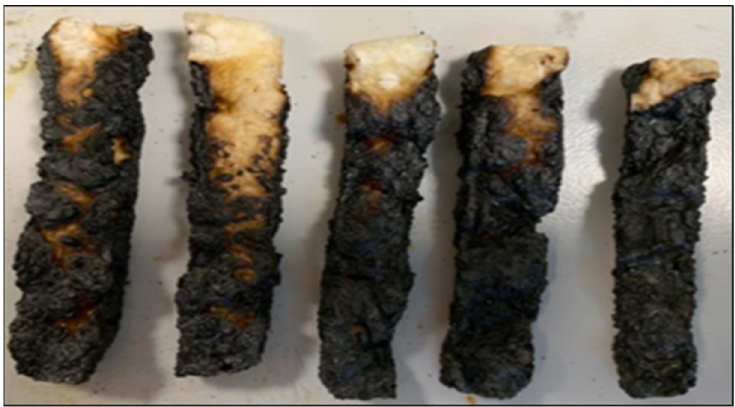
Figure 9. Insulation specimens after applying the UL94 V fire